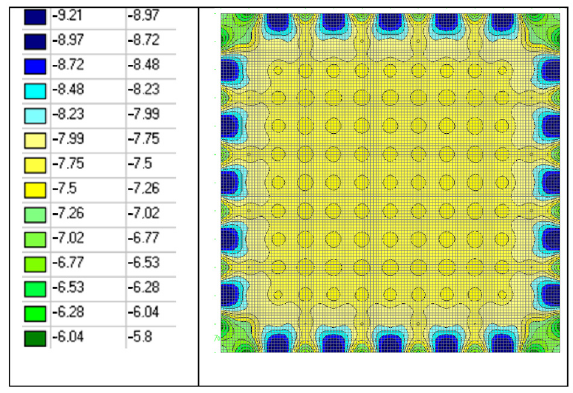
Fig. 10. Settlements of the slab (mm). Stiffness of the piles 47.5